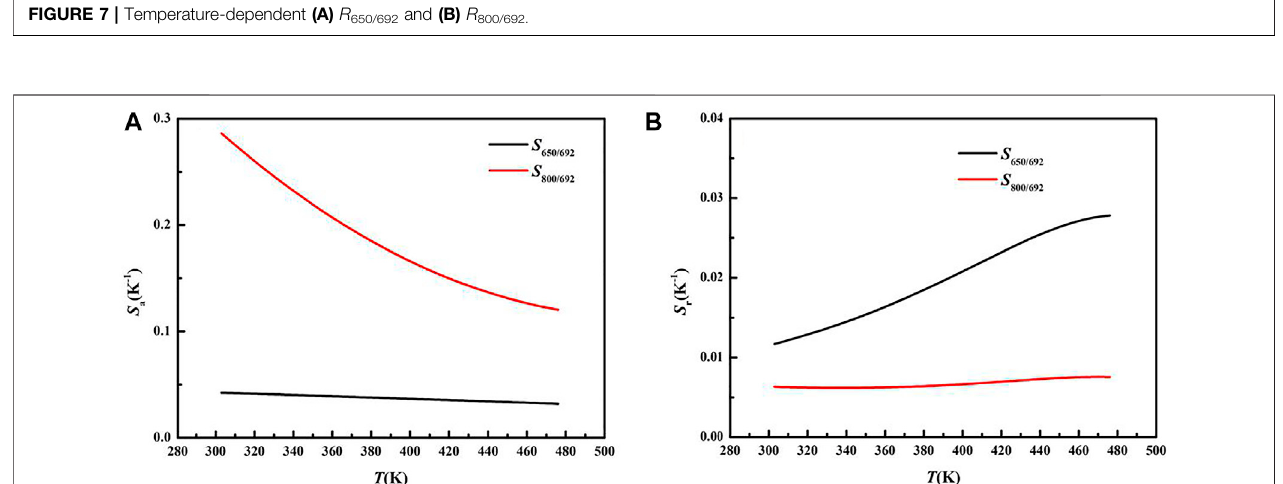
FIGURE 8 | Temperature-dependent (A) S a and (B) S r of I 650 / I 692 and I 800 / I 692 , respectively.